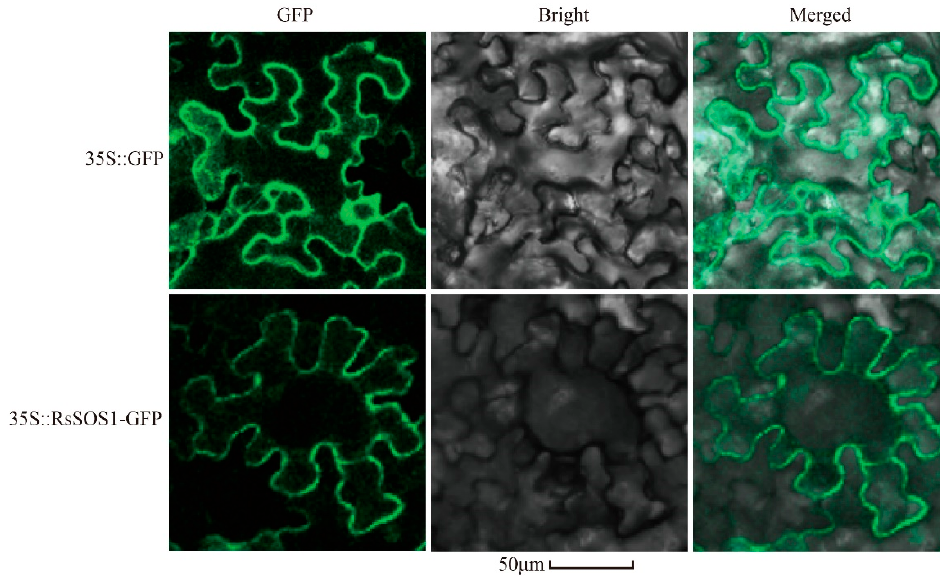
Figure 2. The subcellular localization of RsSOS1 in tobacco cells.